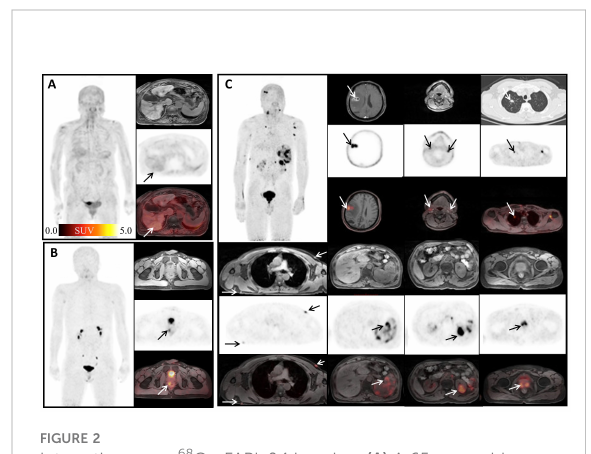
2-year history of rectal Crohn ’ s disease, arrows, rectal Crohn ’ s disease, SUV max 5.22; (C) a 56-year-old man diagnosed with disease of disseminated non-tuberculous mycobacteriosis. The maximum intensity projection (MIP) image shows various FAPI- avid nodules: brain (SUV max =2.61), cervical lymph nodes (SUV max =1.81), upper lobe of right lung (SUV max = 1.74), subcutaneous nodule on the left chest (SUV max = 3.52), spleen (SUV max = 2.03), left kidney (SUV max = 2.76), and prostate (SUV max =